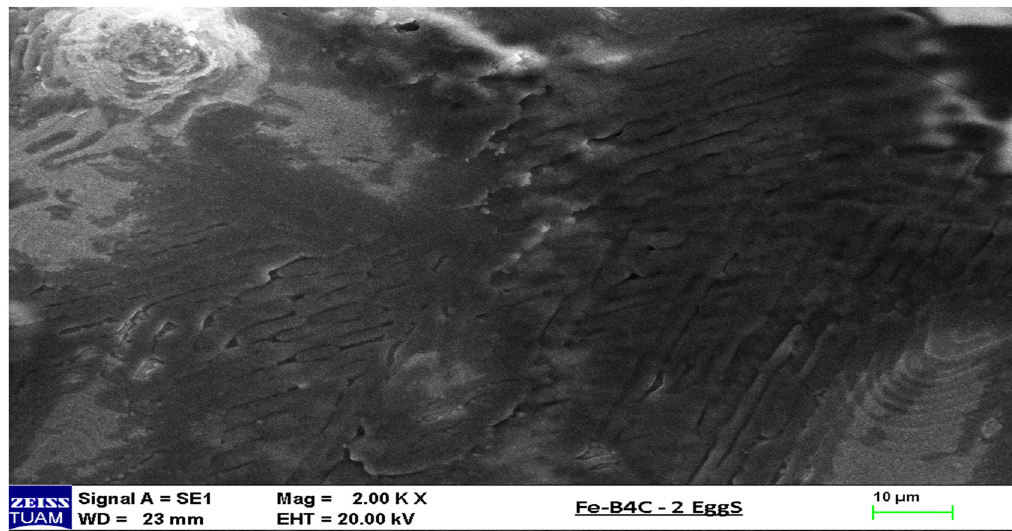
Figure 7: SEM picture of 91.66% Fe – 1.66% B 4 C – 6.66% egg